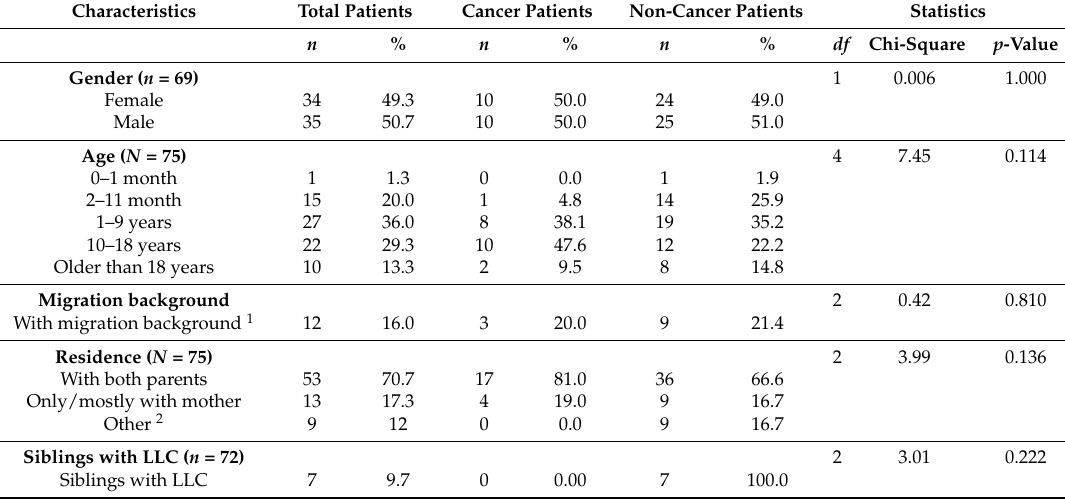
Table 2. Patient characteristics.